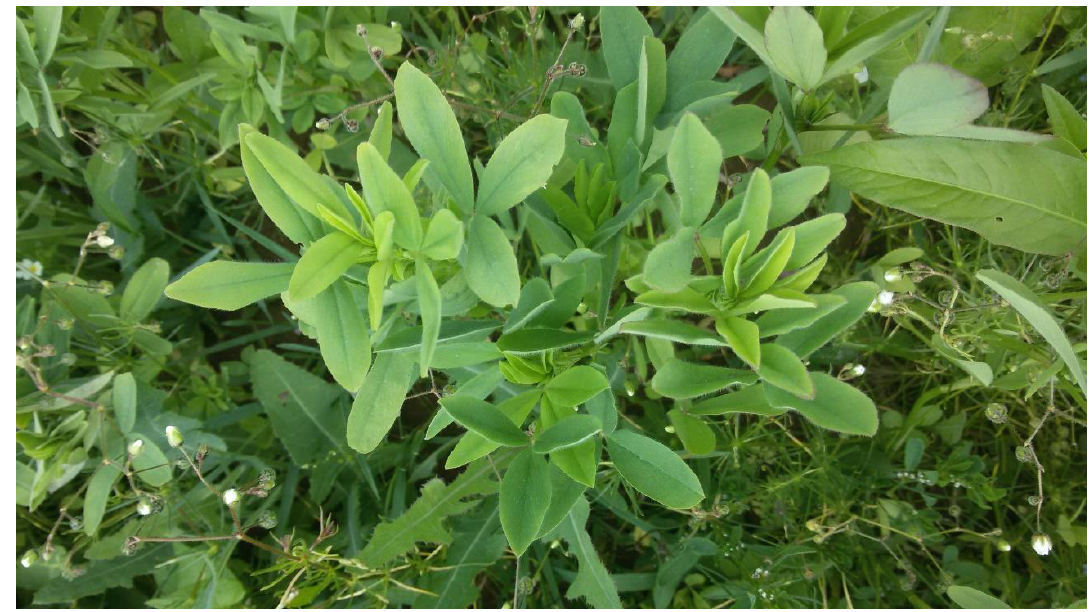
Figure 5. Trifolium alexandrinum L. growing on the experimental plot.